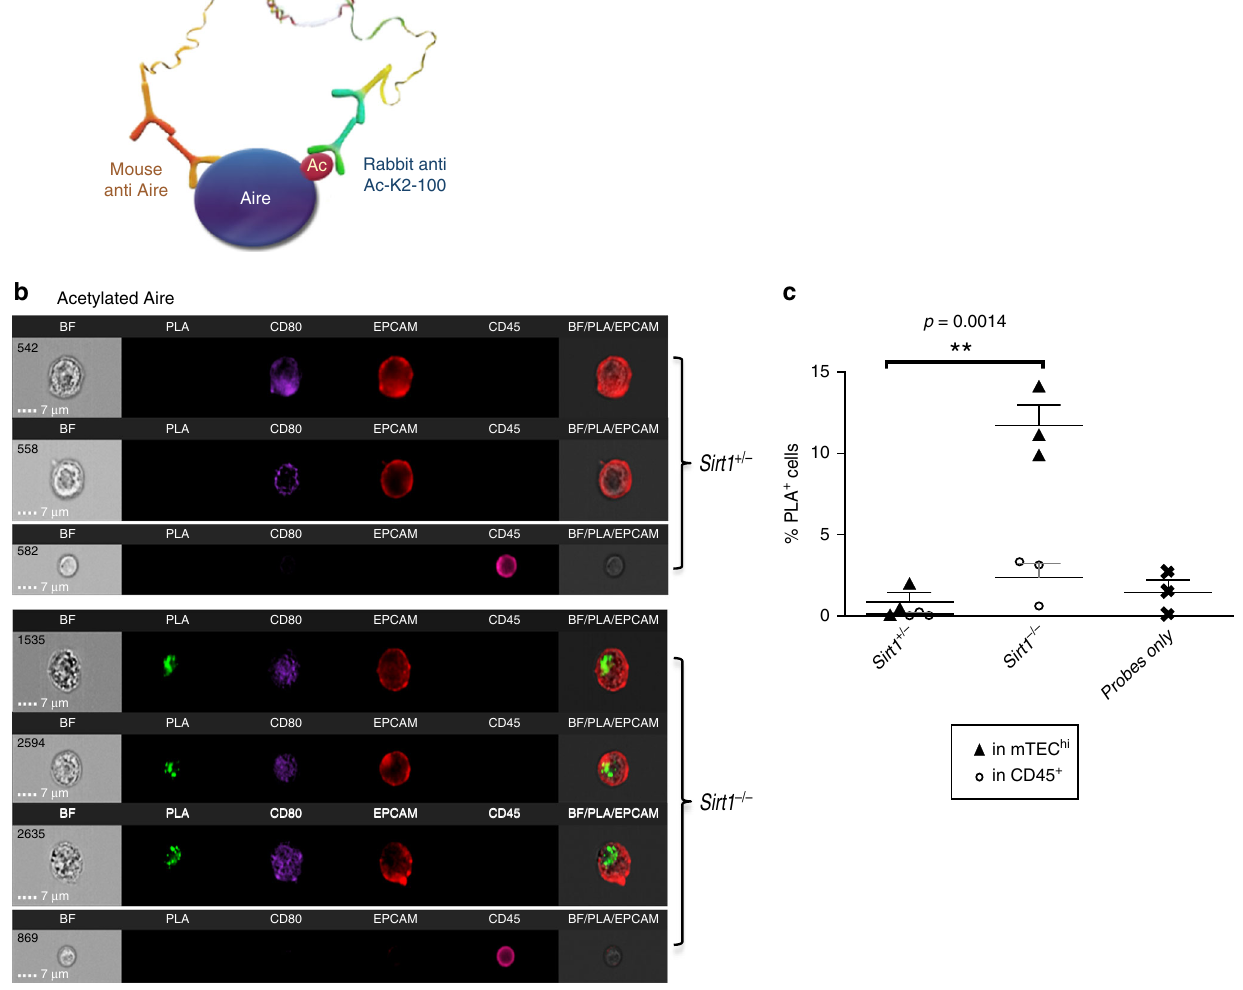
Fig. 3 PLIC quantitative analysis of protein post-translational modi fi cation in mTECs. a A graphical scheme illustrating PLIC analysis of acetylated Aire, using mouse anti-Aire #209 antibody, and rabbit anti-lysine acetylation antibody. b PLIC analysis showing representative images of Aire acetylation in mTEC hi and CD45 + cells isolated from Sirt1 + / – and Sirt1 – / – mice. Presented as (left to right): bright fi eld (BF), PLA (green), staining of CD80 (PB), EpCAM (APC), CD45 (APC/Cy7), and BF/PLA/EpCAM overlay (merged). Scale bar 7 μ M. c Quantitative analysis of Aire acetylation (presented as the percentage of PLA + cells) in mTEC hi or CD45 + cells isolated from Sirt1 + / – and Sirt1 – / – mice. Shown are values from three independent experiments. Each point on the graph (triangle for mTEC hi , circle for CD45 + , and cross for probes only) represents an average value of single independent experiment, calculated from 2 to 4 biological replicates, +s.e.m; ** p -value = 0.0014 (independent student